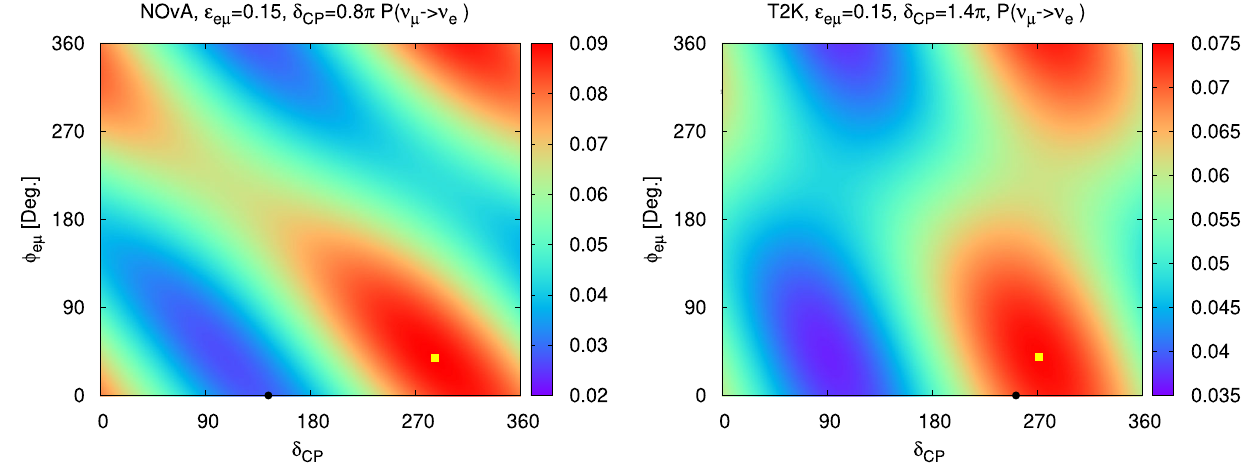
Fig. 4 Oscillograms of P μ e for ε e μ = 0 . 15, NH, plotted with respect to variation of standard CP phase δ CP and the NSI phase φ e μ . The left (right) plot corresponds to NOvA (T2K) baseline